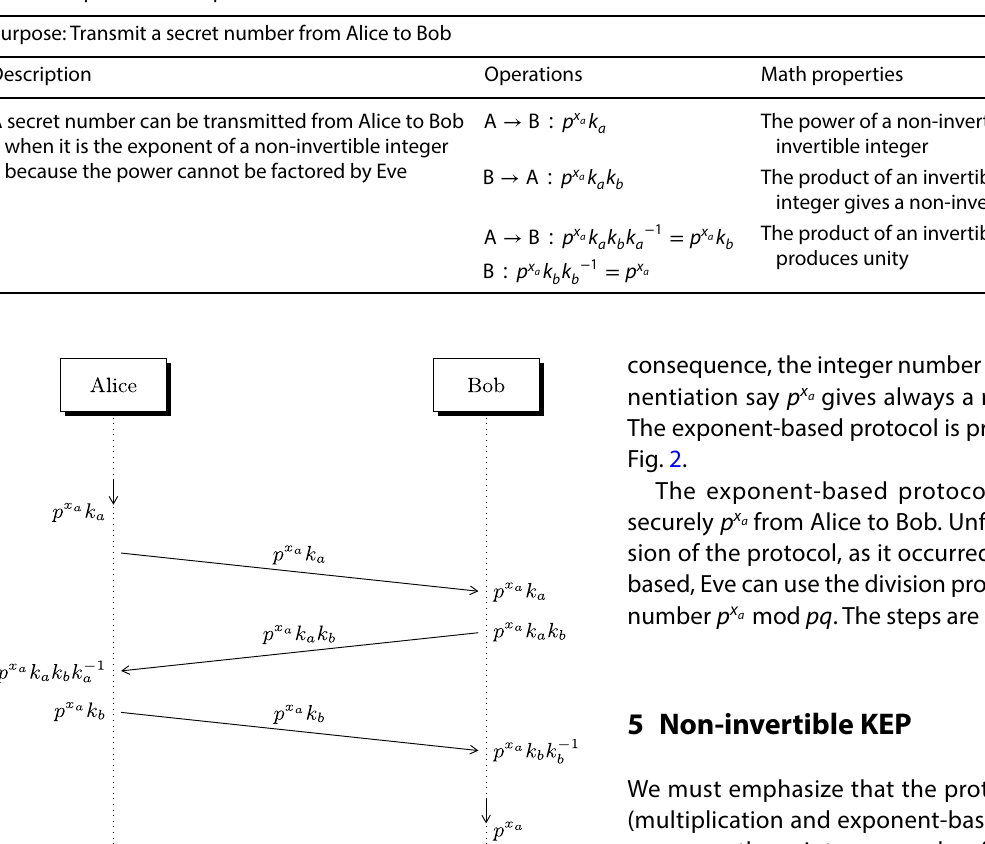
multiplication-based protocol as indicated in Table 3 to derive the secret value p ⋅ x